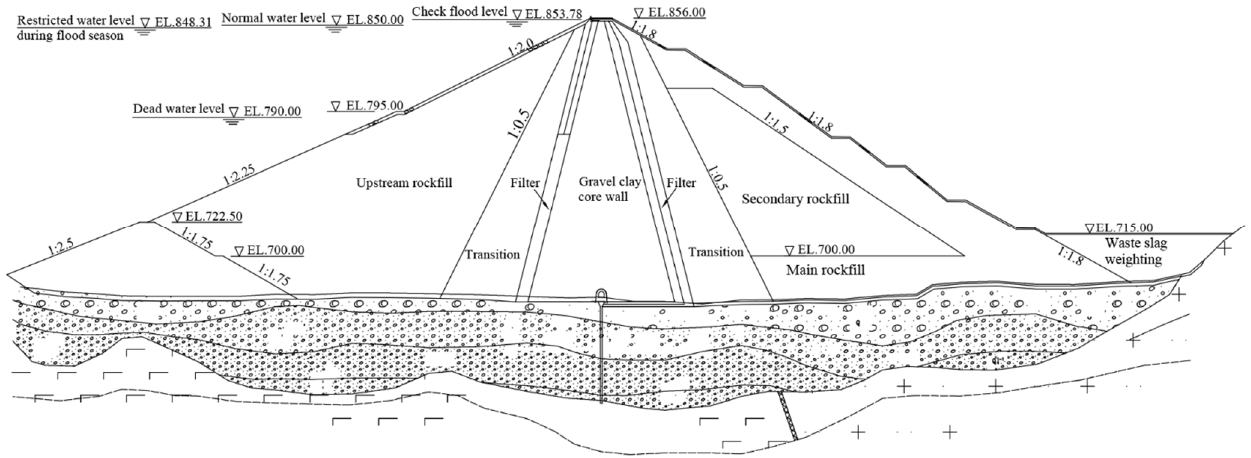
Figure 7. Typical cross section of the